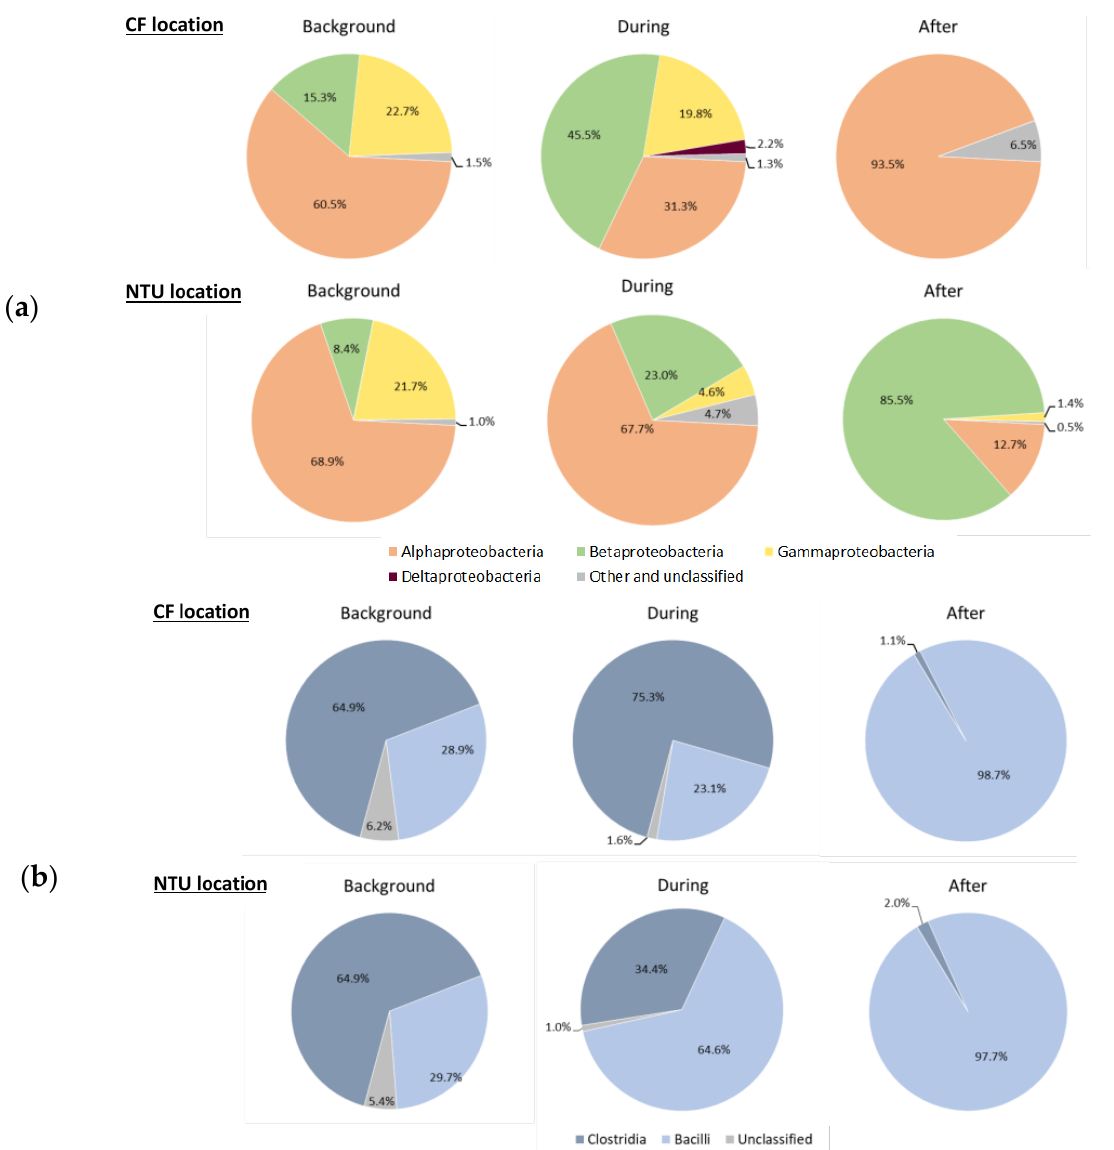
Figure 6. Classes of Proteobacteria ( a ) and Firmicutes ( b ) on background days as well as during and after the Asian dust storm. The classes with the relative abundance of less than 1% were not listed. Generally, specific phylotypes were observed in the bacterial communities at different periods and locations. In particular, extensive populations of Rhizobium and Stenoxybacter were detected in CF-background samples. Roseomonas dominated in the NTU-background and CF-background samples. The populations of Ralstonia and Delftia were detected in CF-during samples, and Methylobacterium was detected predominately in NTU-during samples. Furthermore, Streptococcus populations were detected at a relatively high level in the communities during and after an ADS at